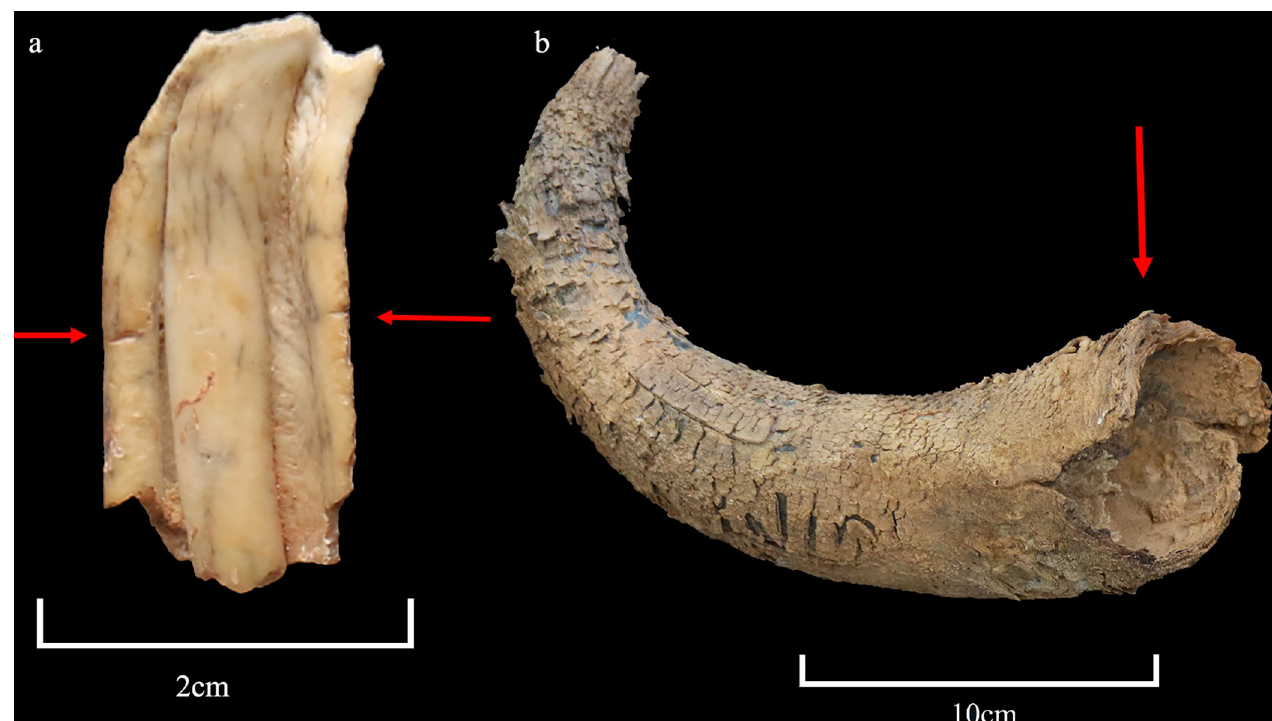
Fig 17. Detail of anthropic marks. a. Cattle left upper molar #0056 presenting three aligned cut marks on its buccal face. b. Chop mark visible on the basal portion of the cattle horn